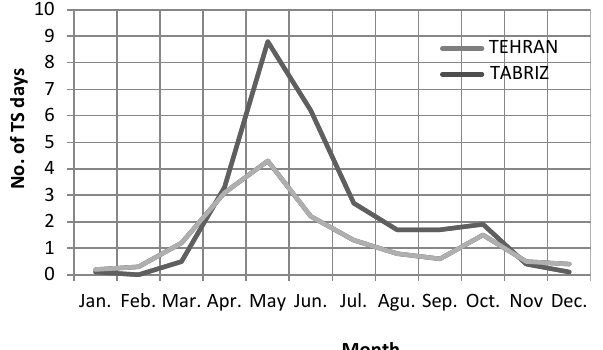
Fig. 2. Monthly average of 15yr period (1991–2005) thunder storm days for Tabriz (dark gray line) and Tehran (light gray line). Fig. 3. Climatology of thunderstorm days (annual) in Iran in the period of 1991 to 2005.